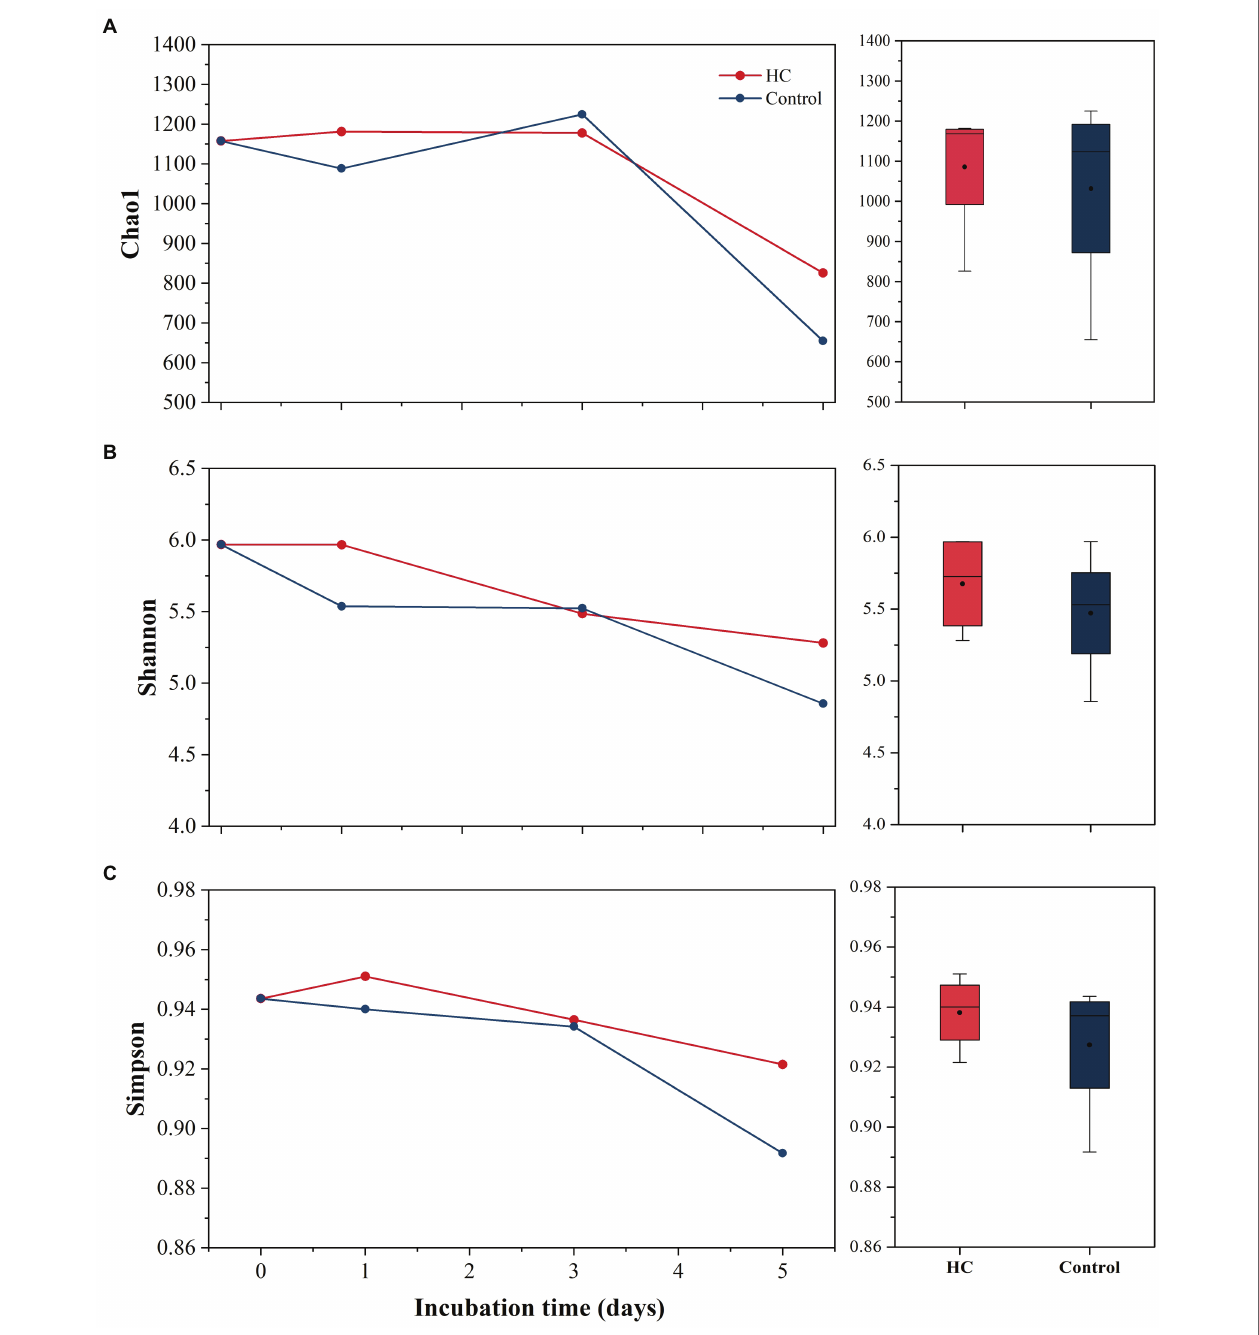
FIGURE 3 | Bacterioplankton community richness (A) and diversity (B,C) in elevated p CO 2 (HC, about 1,000 μ atm) and ambient p CO 2 (Control, about 380–410 μ atm) conditions. Changes in Chao1 index, Simpson’s index, and Shannon’s index over time are shown on the left. Boxplots on the right show responses of Chao1 index, Simpson’s index, and Shannon’s index to elevated p CO 2 throughout the whole